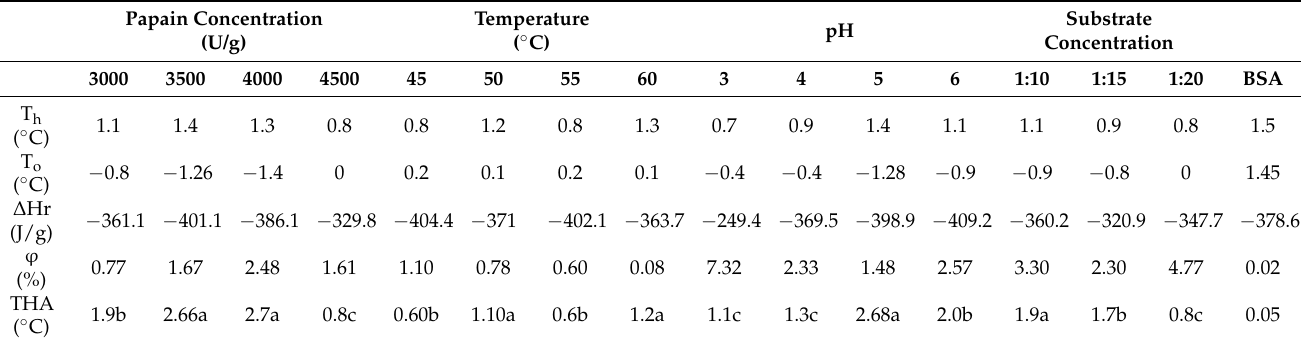
same letter in the same column showed no significant difference ( p ≥ 0.05).